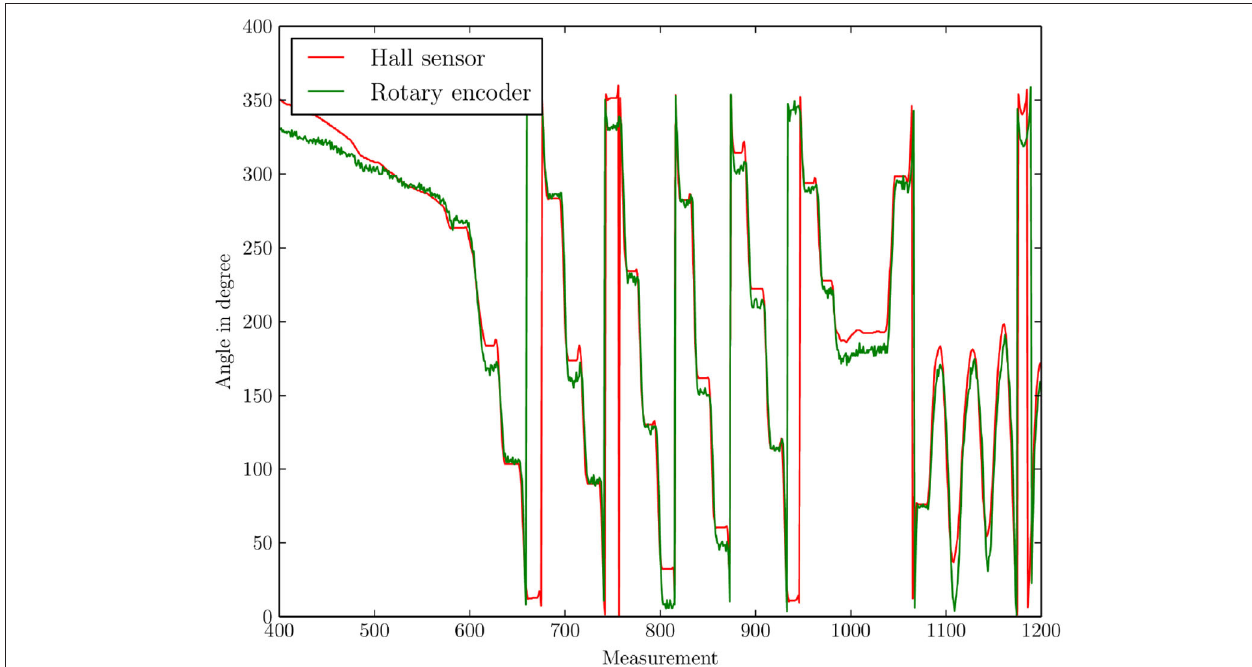
FIGURE 5 | Comparison of the angles measured with the small-sized magnetic rotation encoder and the reference encoder (as ground